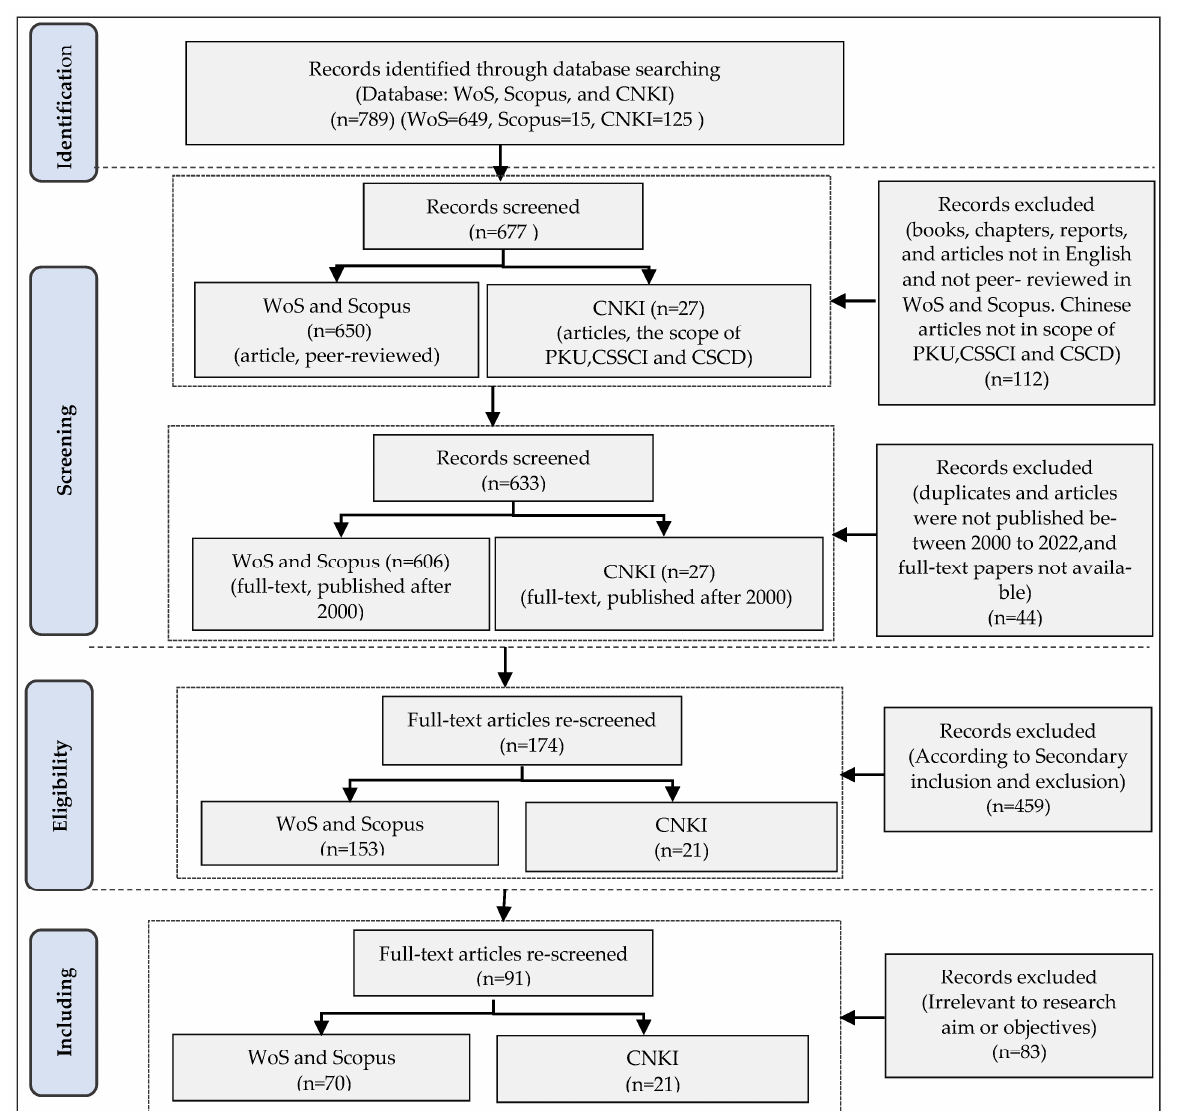
Figure 1. Flow diagram of article selection process.